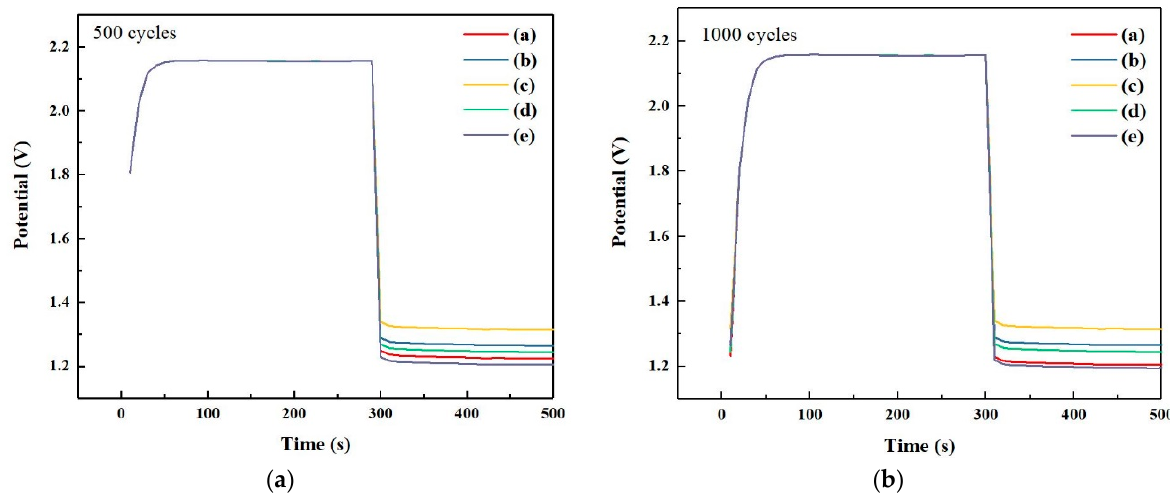
Figure 8. Durability test results after ( a ) 500 cycles and ( b ) 1000 cycles. Samples (a), (b), (c), (d) and (e) denote the samples with electroplating Mn:Ni ratio of 1:0, 1:0.25, 1:0.67, 1:4, and 0:1 respectively. Table 3. Continuous charge, discharge, and overall potential of the as-prepared samples after 500 cycles and 1000 cycles. Sample